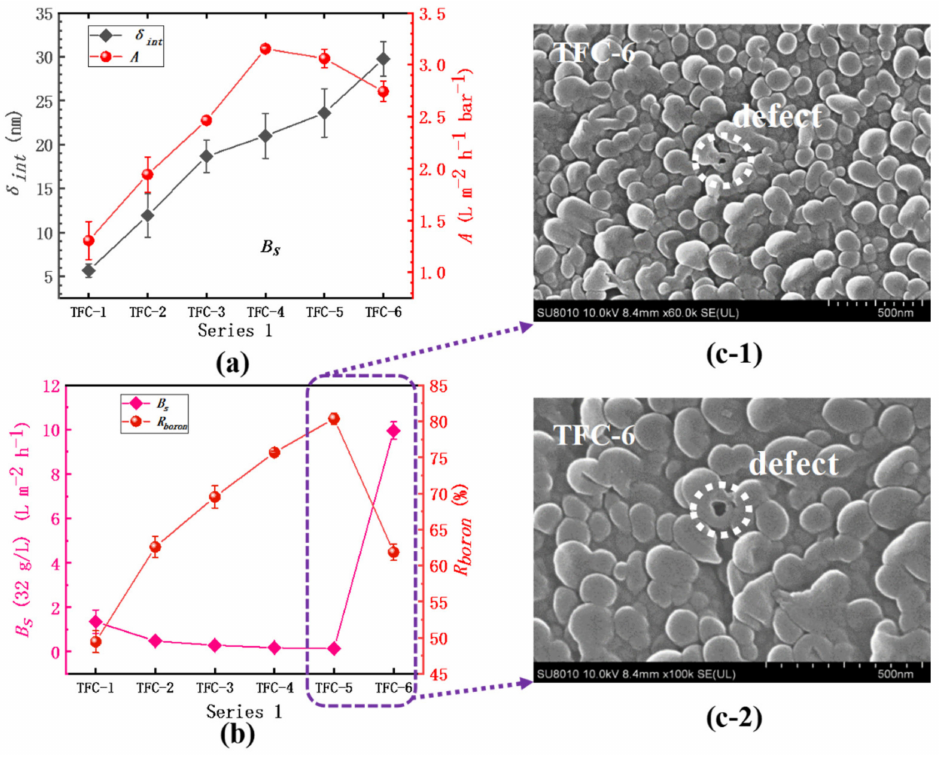
Figure 10. Series 1. ( a ) The variation in water permeability ( A ) and the intrinsic thickness ( δ int ); ( b ) the analysis of the salt permeability ( B s ) and the boron rejection ( R boron ); ( c-1 ) and ( c-2 ) SEM image of TFC − 6. Table 3. The analysis of correlation coefficients in series